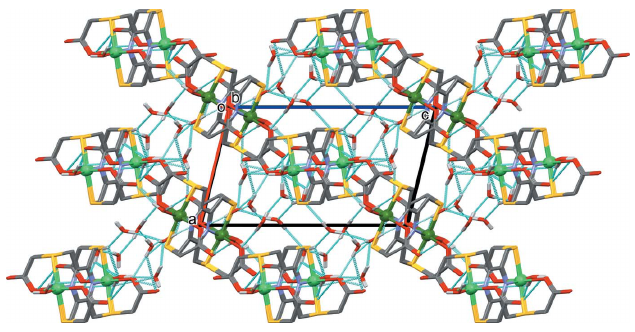
Figure 5 A view along the b axis of the crystal packing of complex I . Hydrogen bonds (see Table 2) are shown as dashed lines. For clarity, C-bound H atoms have been omitted. (atom Ni1 light-green ball; atom Ni2 dark- green ball).